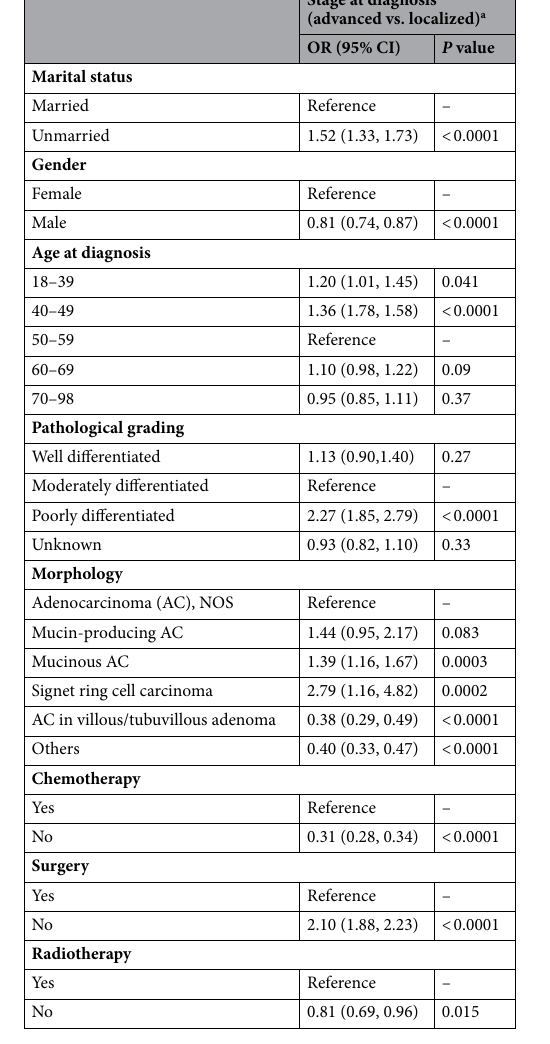
Table 3. Logistic regression analysis for the association of marital status and stage at diagnosis in colorectal cancer patients. a Multiple imputation-based